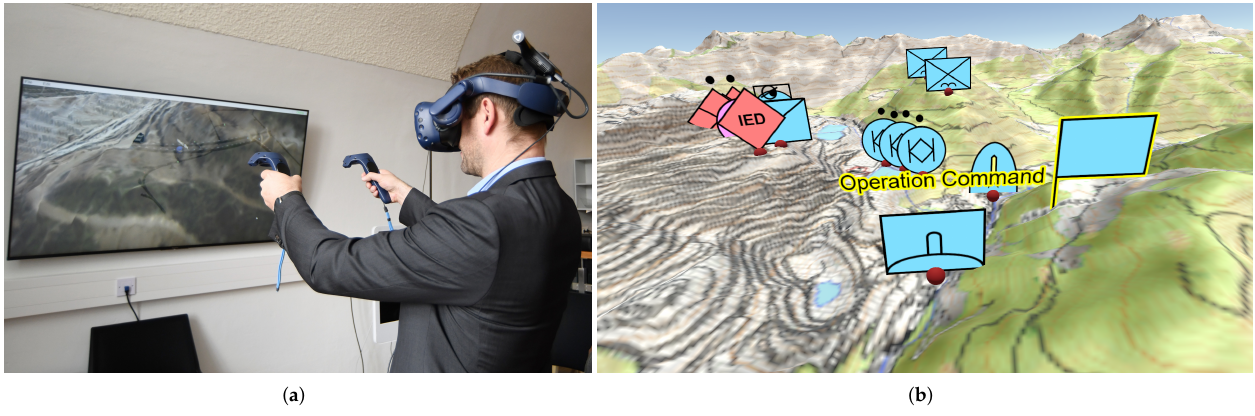
Figure 2. Usage of virtual reality (VR) for mission preparation. ( a ) VR user. (Picture: OEBH/Seeger). ( b ) Tactical symbols inside virtual reality (VR). (Picture: